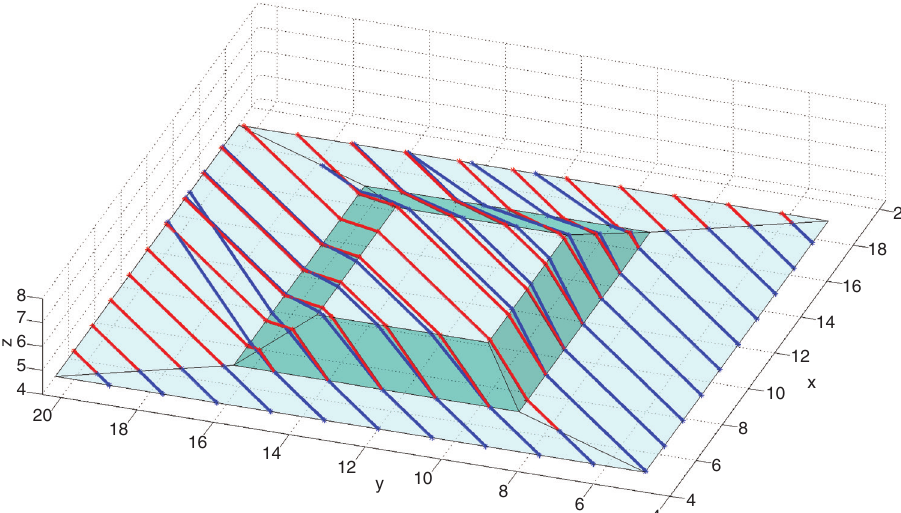
Figure 31 Geodesic and constant angel paths on a discrete ramped